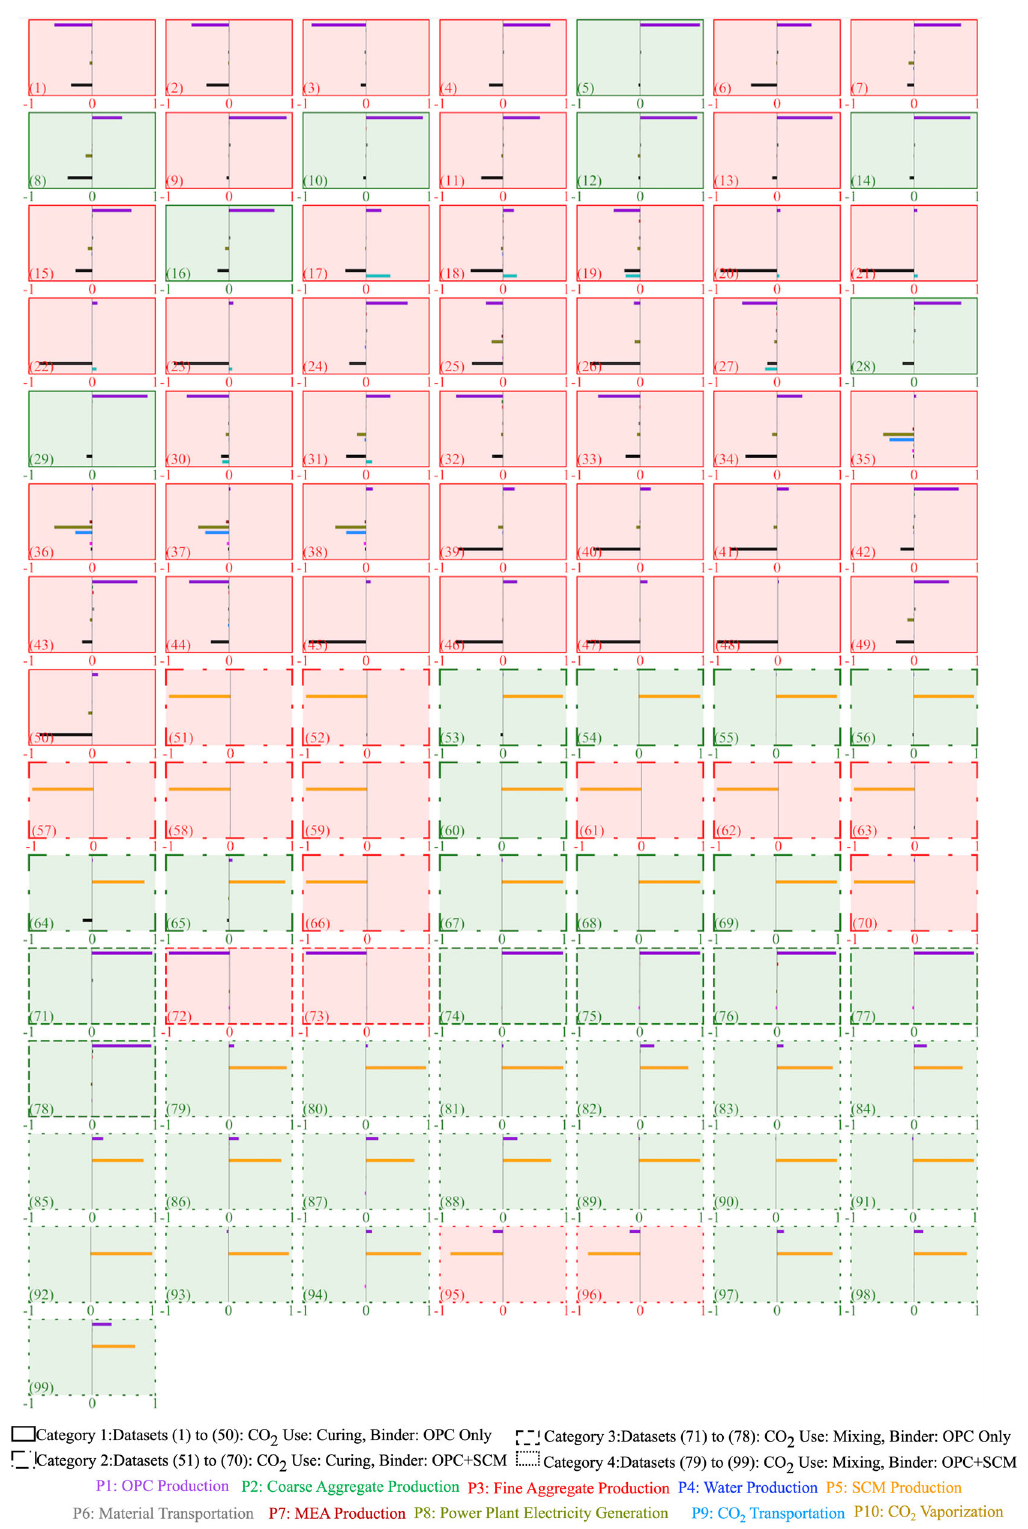
Fig. 5 δ indices quantifying in fl uence of the difference between the CO 2 emissions from the 13 processes of CCU and conventional concrete production on the net CO 2 bene fi t. A process with a greater δ index value has a greater in fl uence on the net CO 2 bene fi t than a process with a lower δ index value. The parenthesized value in the lower left corner is the dataset